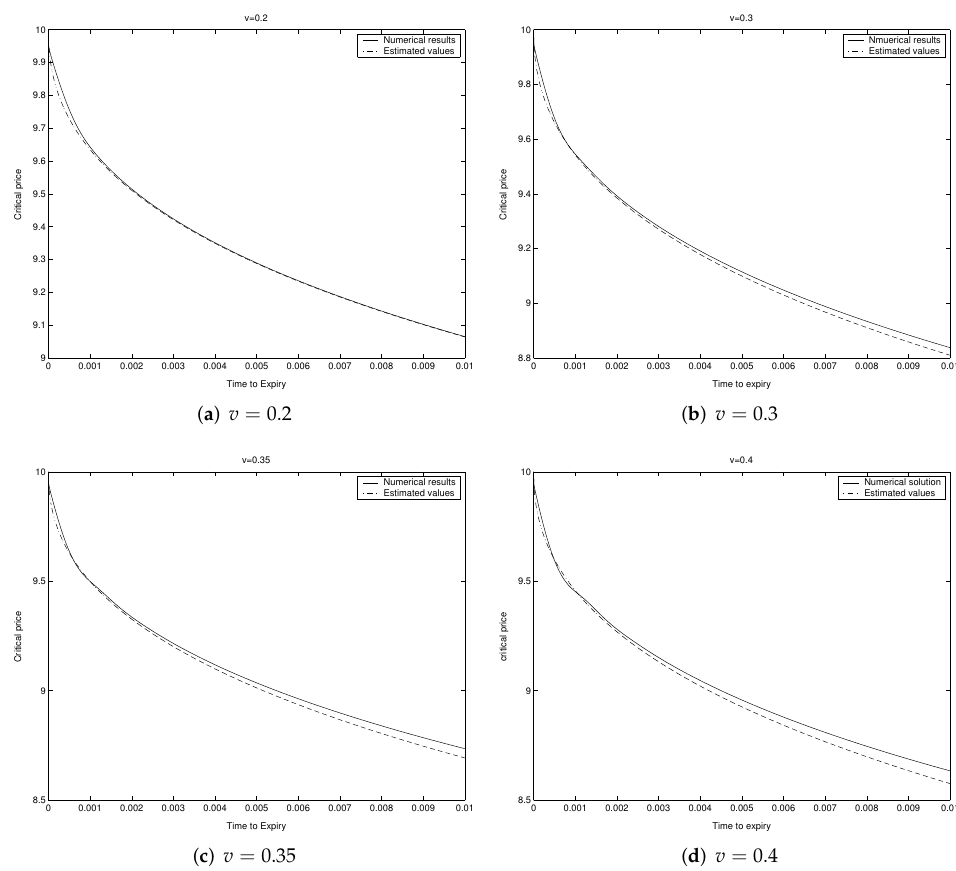
Figure 2. Comparison of the numerical results and the estimated